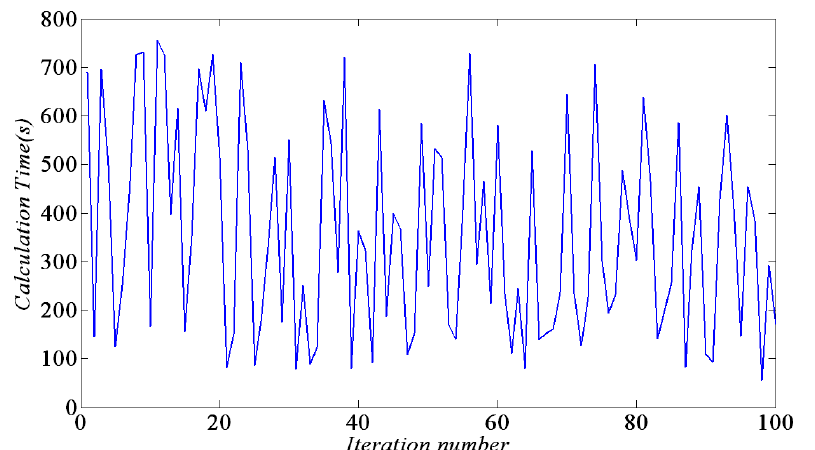
Figure 12. Calculation time of the PSO